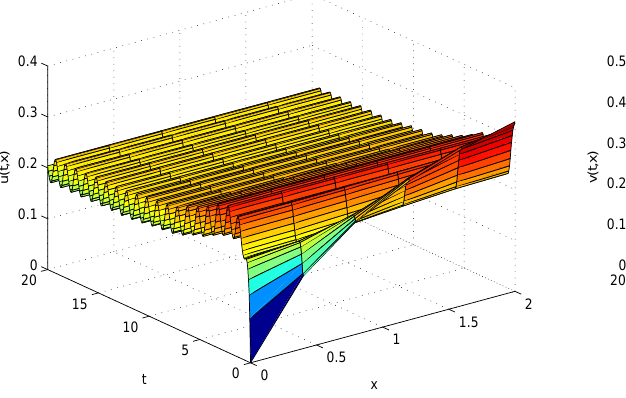
Fig. 1. Periodic prey solution with respect to the time and space variables.